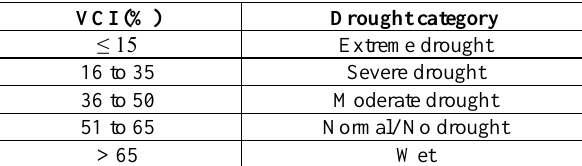
Table 1. Thresholds used to update the vegetation condition index (VCI) and related drought categories based on rainfall data.